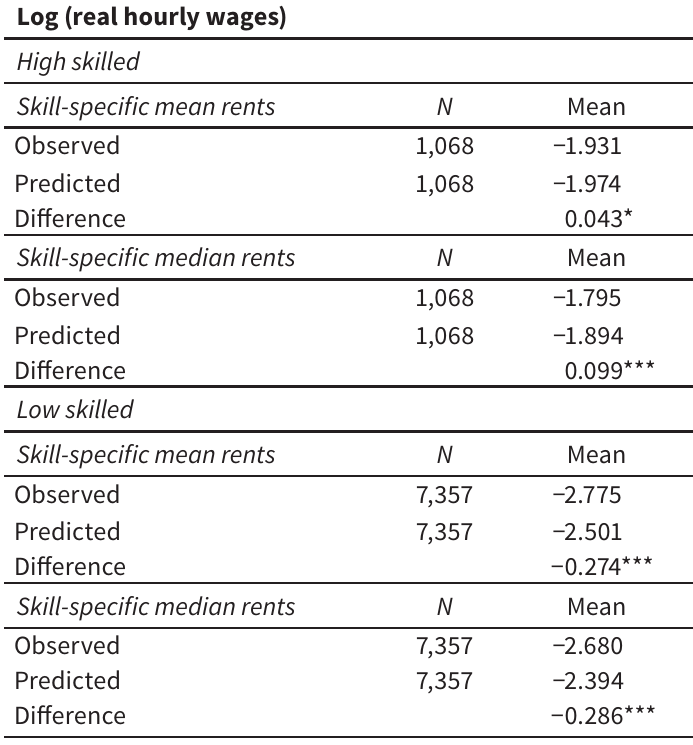
Table A9 Observed and predicted real wage differences using different measures of living costs, metropolitan